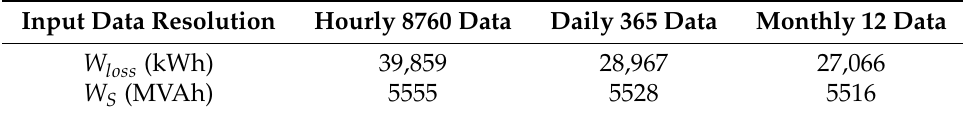
Table 10. The objective function values without installed DGs for the used input data resolutions.